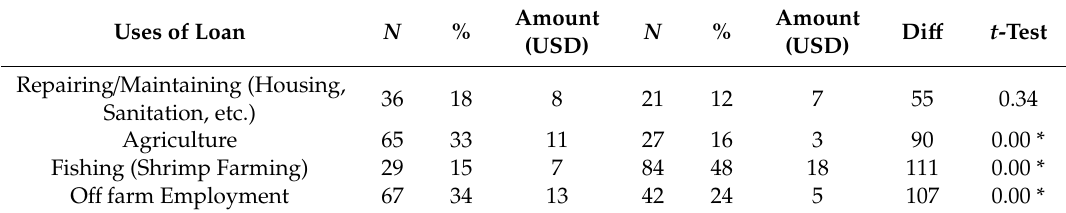
Table 10. Uses of loan and proportion wise